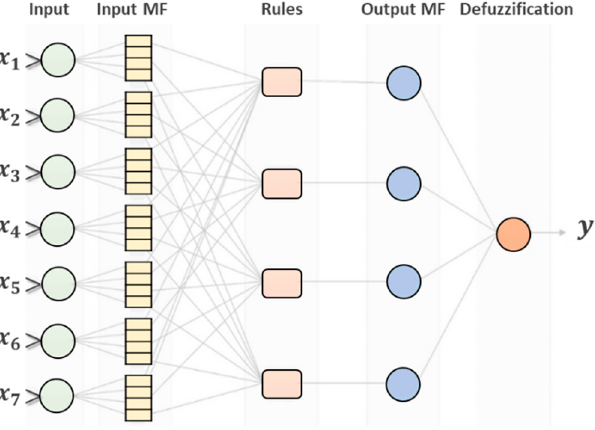
Figure 5. Considered NF system architecture for compressive strength prediction.